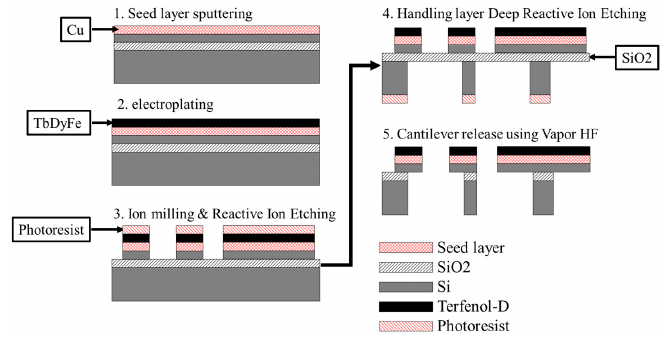
Figure 6. Fabrication process of the magnetostrictive bi-material cantilevers.